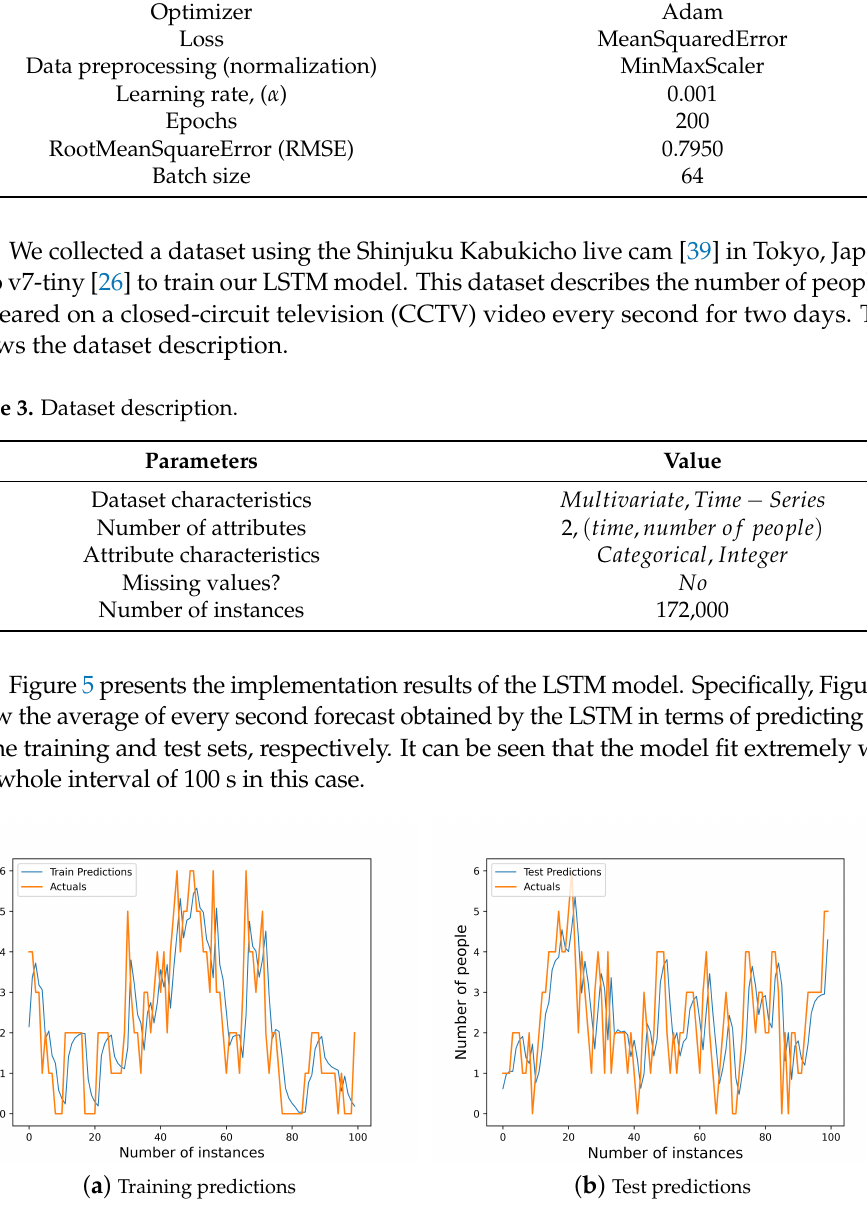
Figure 5. The implementation results on 1st edge node and 2nd edge